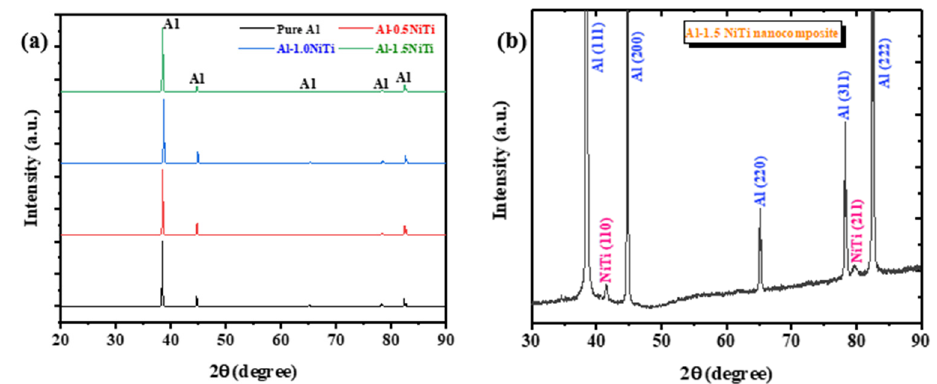
Figure 1. XRD spectra of the: ( a ) extruded Al-NiTi nanocomposites and ( b ) the enlarged XRD pattern of Al-1.5NiTi